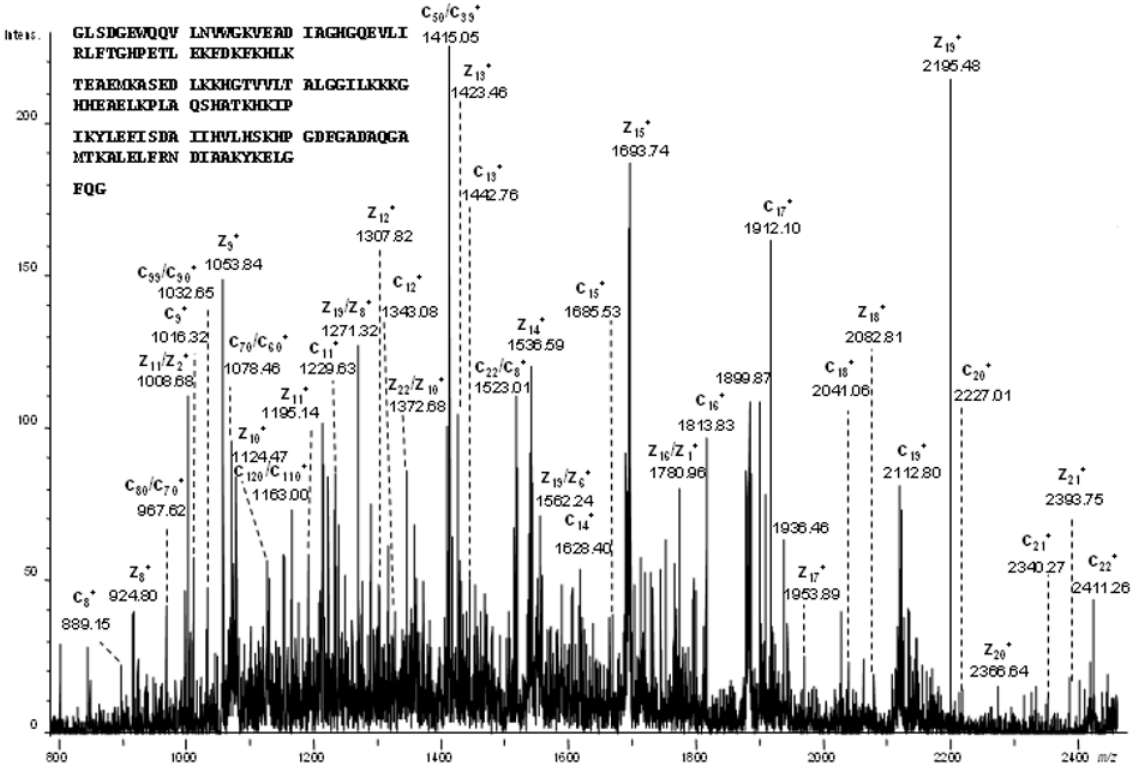
Figure 7. Top-down by NanoMate-ETD MS 2 of the [M+16H + ] 16+ ion at m/z 1060.66 corresponding to apomyoglobin. Inset: amino acid sequence of horse apomyoglobin. Acquisition time 30 s. Sequence coverage: